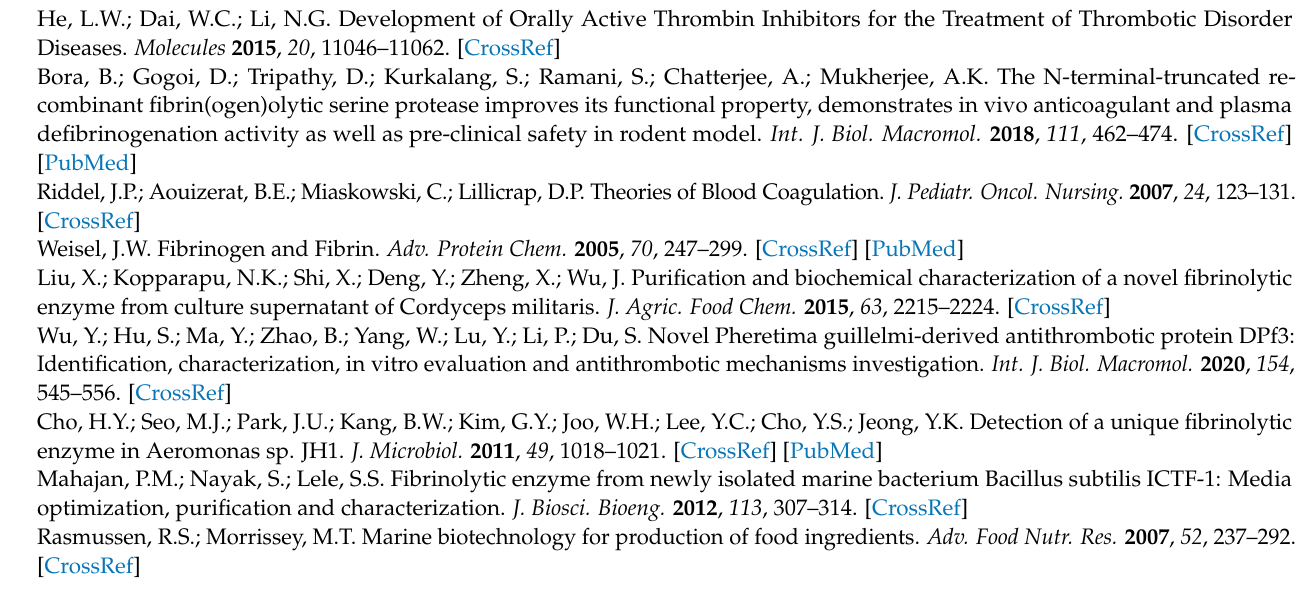
GIDSSHPDLK (1652.85 Da) and YPSVIAVGAVNSSNQR (1661.86 Da). (b) Prediction of the conserved domain of Velefibrinase. (c) Phylogenetic analysis of Velefibrinase and some other typical pep- tidases from the S8 family using the neighbor-joining method. (d) Multiple sequence alignment of Velefibrinase and some other typical peptidases from the S8 family. Figure S3: The kinetics of Velefibrinase on (a) fibrinogenolytic and (b) fibrinolytic activity. The Km and Vmax of Velefibrinase against various concentrations of fibrinogen and fibrin were determined by Lineweaver–Burk plot. Figure S4: The comparison of transparent area of Velefibrinase in (a) plasminogen-rich fibrin plate and (b) plasminogen-free fibrin plate. Figure S5: The hemolytic activity for erythrocyte in vitro and hemor- rhagic activity in vivo of Velefibrinase were evaluated. (a) Aliquots of 1.0 mL 5% washed suspension were incubated with different concentrations of Velefibrinase at 37 ◦ C for 1 h. As for negative control, the Velefibrinase was replaced with 1% Triton X-100. The morphology of erythrocytes was observed under an optical microscope (200 × ). (b) Aliquots of 0.1 mL Velefibrinase with different concentrations were injected intradermally into mice, and the group receiving isotonic saline alone served as control. After 2 h, mice were sacrificed; skin was removed and observed. Table S1: The morphological and physiological characteristics of B. velezensis Z01. Table S2: The effect of different concentrations of Velefibrinase on hemolysis rate of wash erythrocytes from